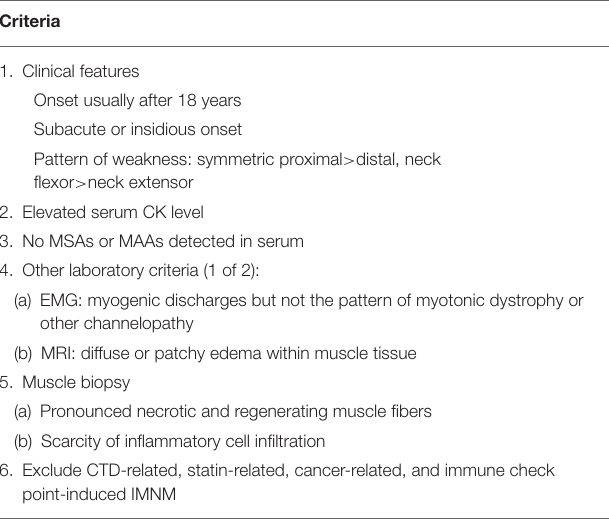
TABLE 1 | Diagnostic criteria of seronegative IMNM.